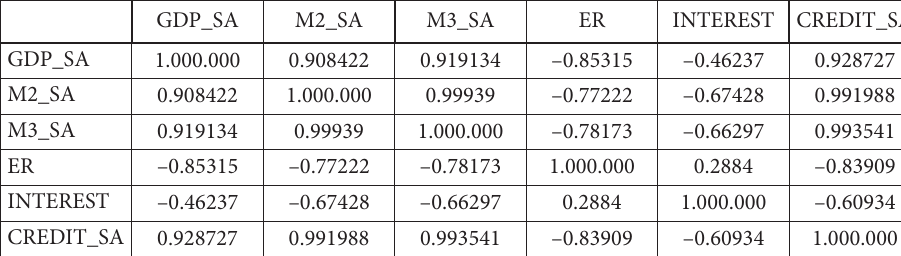
Table 2. Correlation matrix of the variables for Czech Republic (source: authors’ calculations)